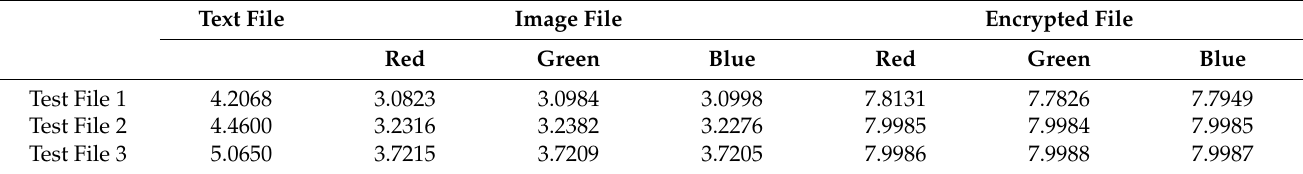
Table 2. Entropy comparison of the original text file with its image version and the encrypted image.